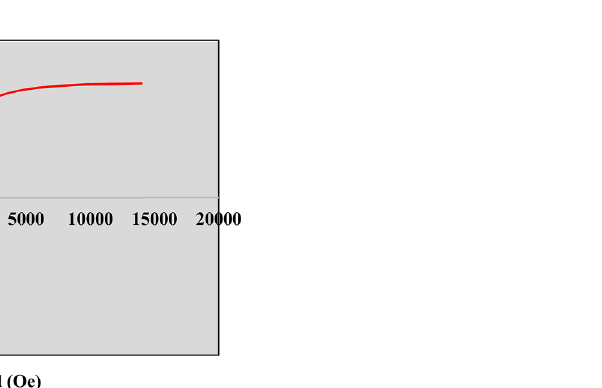
Figure 7. XRD profile of Fe 3 O 4 NPs and the Fe 3 O 4 @ Fritillaria /Pd nanocomposite.